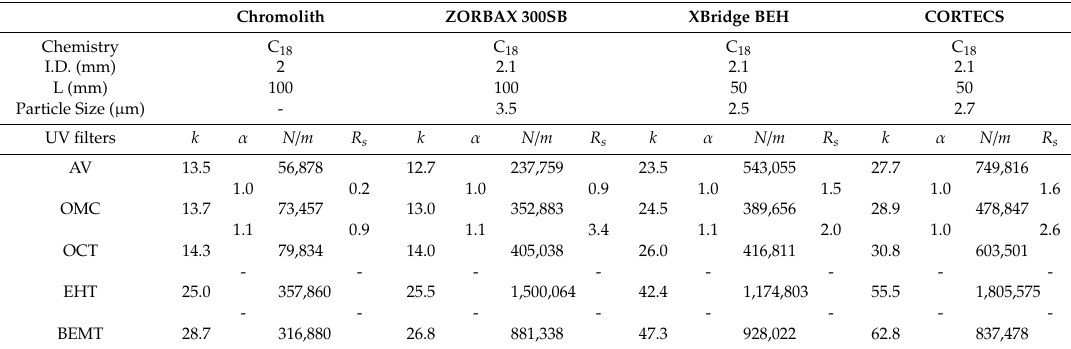
Table 1. Separation characteristics of the UV filters on di ff erent